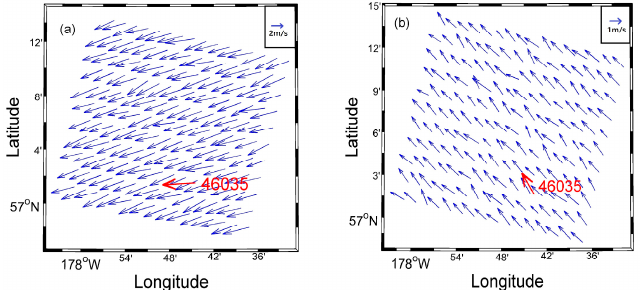
Figure 5. ( a ) SAR-retrieved wind speed using the C-2PO model and retrieved wind directions without ambiguities derived from PCC between the VV and VH channels; ( b ) DWF wind speeds and wind directions.